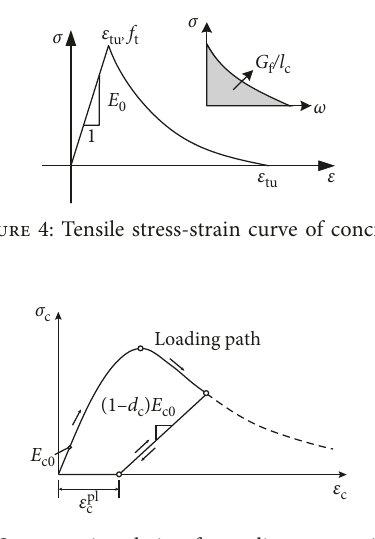
Figure 5: Stress-strain relation for cyclic compressive